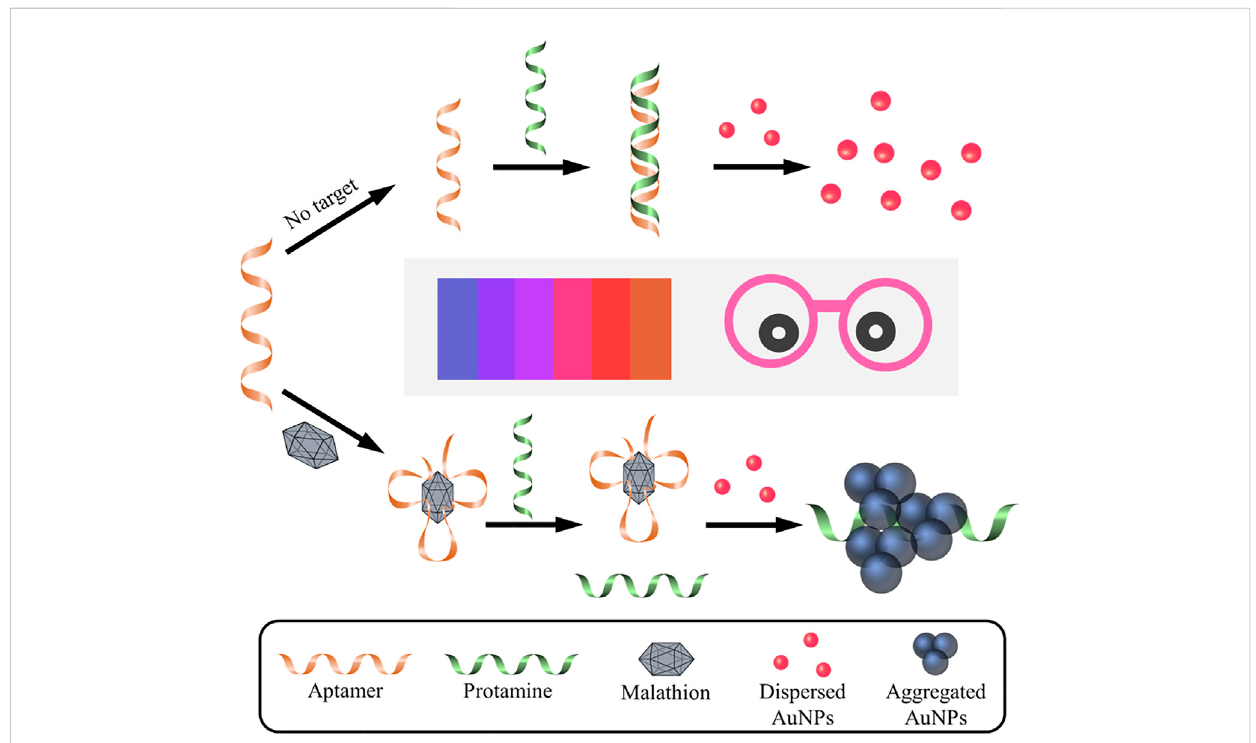
FIGURE 1 Schematic illustration of colorimetric aptasensor for malathion assay based on the utilization of protamine and AuNPs. Without the presence of malathion, aptamer probe is absorbed by protamine via electrostatic interactions, which makes it dif fi cult for protamine to trigger the aggregation of AuNPs. As a result, the AuNPs remain well dispersed and exhibit red in color. On the contrary, the existence of malathion exhibits preferential binding af fi nitytoaptamer,whichisthenunabletocombinewithprotaminemolecule.Consequently,protaminetendstomediatetheaggregationofAuNPs and cause the color change to blue. It is noted that Pro, Apt, and Mal represent protamine, aptamer, and malathion, respectively. The color change of AuNPs solution can easily visualized by the naked eye and is closely related to the concentration of malathion in the